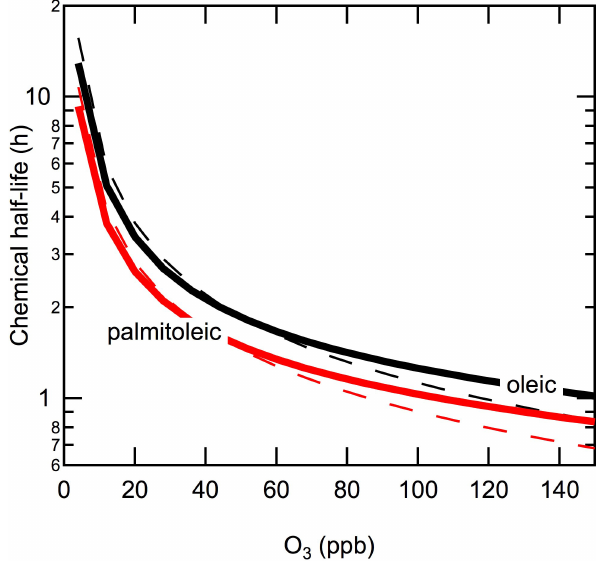
Fig. 7. Chemical half-life of oleic and palmitoleic acids, the most reactive components of the 12-component mixed aerosol matrix with a particle radius of 275nm as a function of gas phase ozone mixing ratio. Bold solid lines represent results from the diffusivity- evolution model variant and the dashed lines are obtained assuming constant diffusivity of the semi-solid aerosol